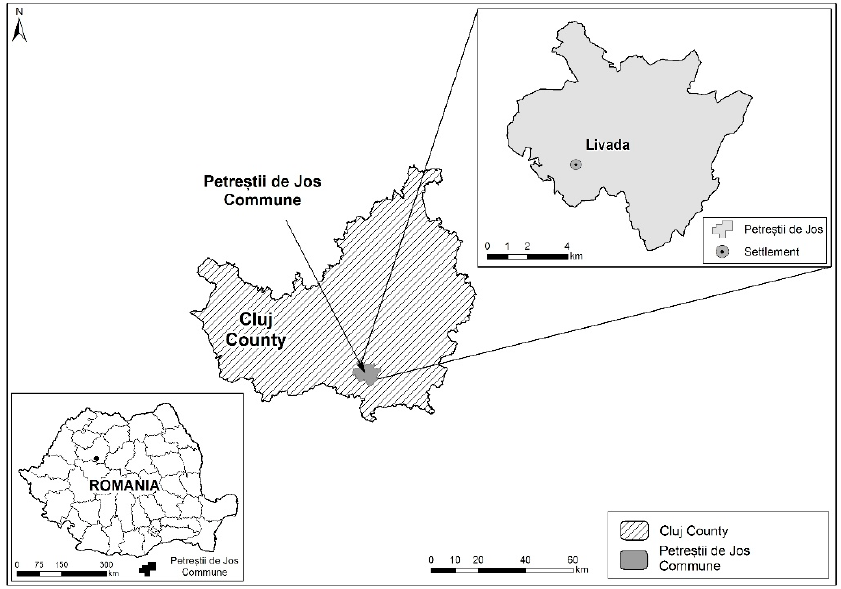
Figure 1. Site location.